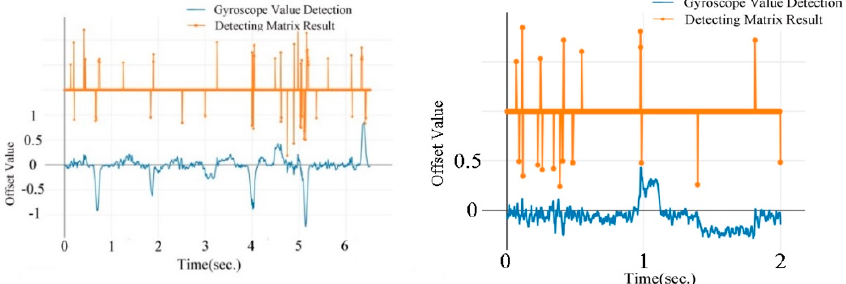
Figure 15. Real-time turning recorded by gyroscopes on urban road ( left ) and highway ( right ).